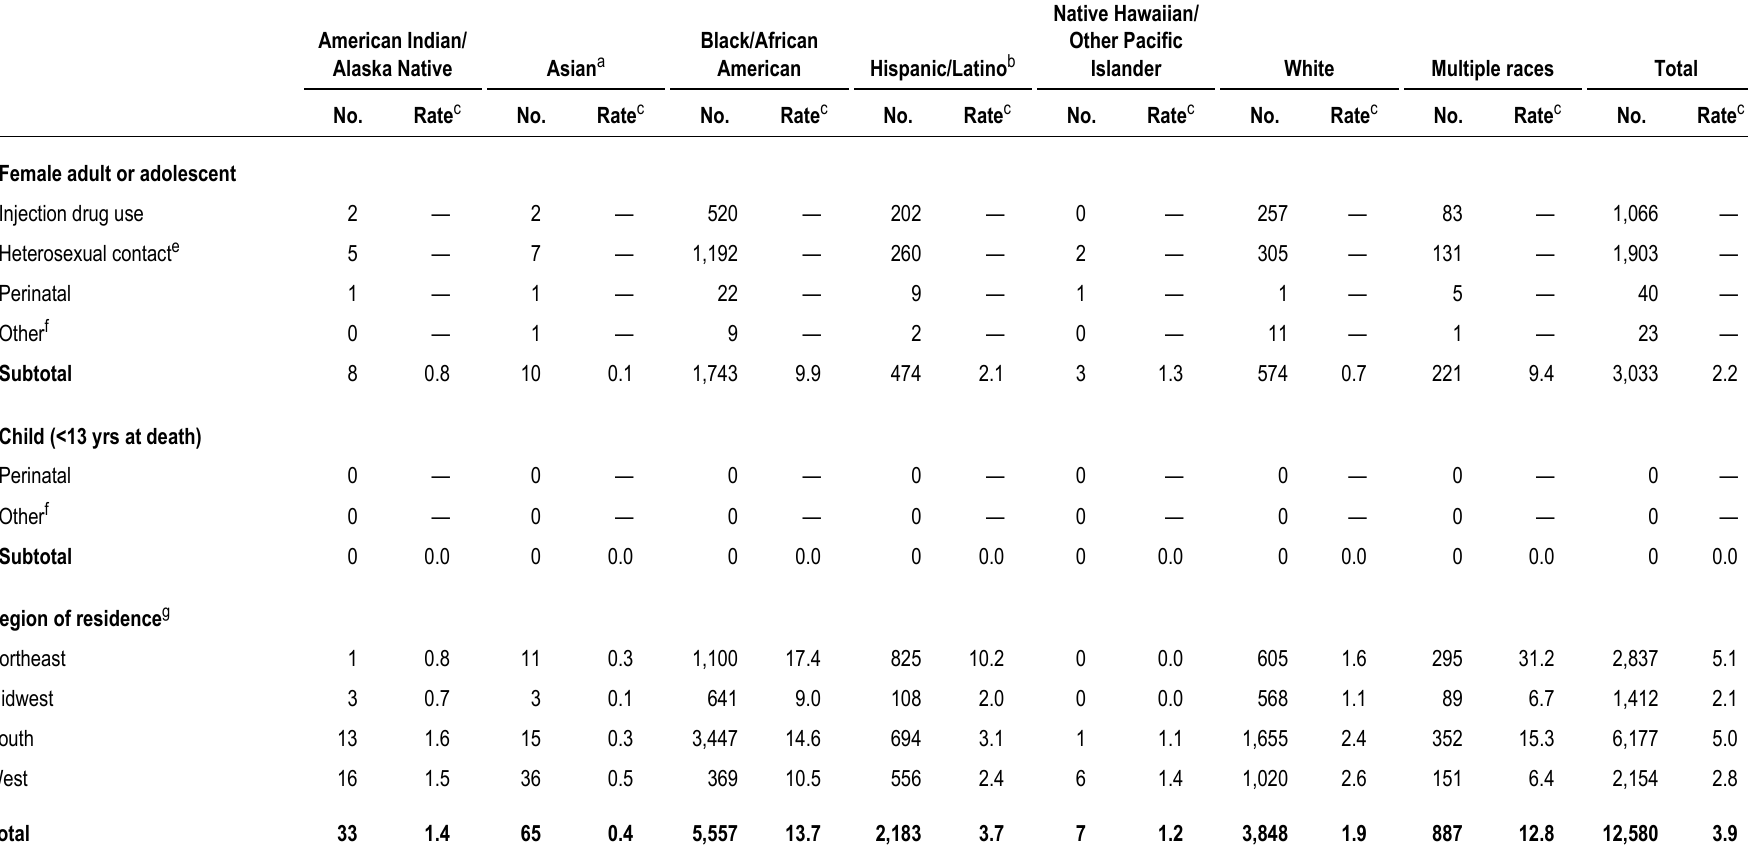
Table 21a. Deaths of persons with diagnosed HIV infection ever classified as stage 3 (AIDS), by race/ethnicity and selected characteristics, 2017—United States (cont)